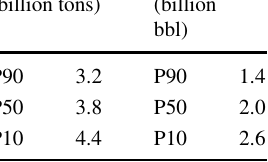
Table 5 Probabilistic result for the yield cutoff of 80 mg HC/g rock, considering the sum of subunits L1, L3, L5, L6 and L7